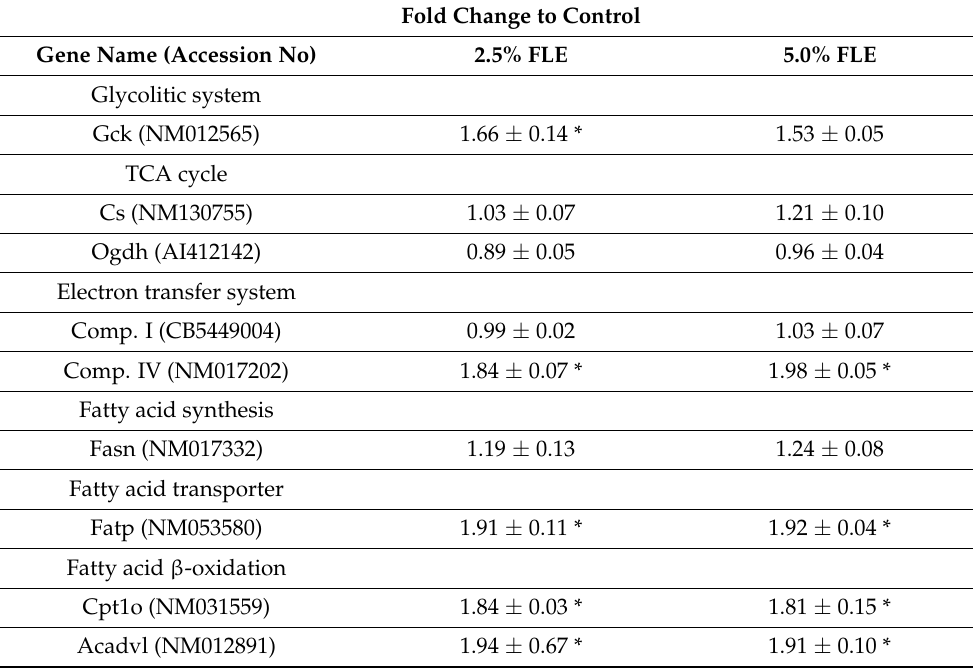
Table 3. Gene expression analysis by real-time PCR in the liver after four weeks of HFD feeding. Fold Change to